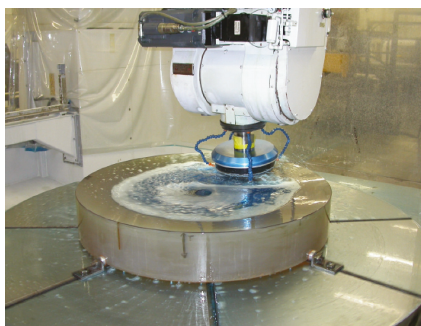
Figure 3: Zeeko 4 m-class CNC machine tool, polishing a ∼ 1 m diameter part